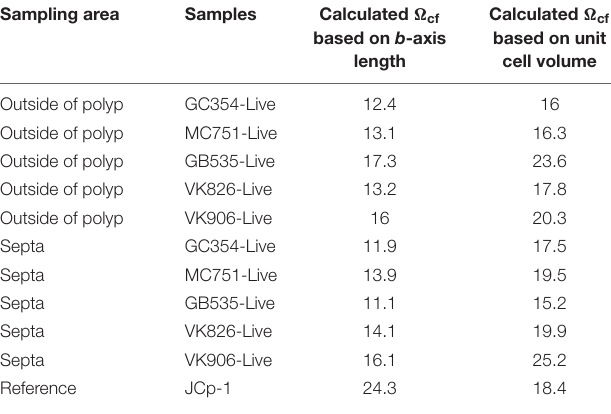
TABLE 2 | Internal calcifying fluid aragonite saturation state ( (cid:127) cf ) estimates in live L. pertusa samples from the Gulf of Mexico as calculated by the relationship between aragonite saturation states and b -axis lengths or unit cell volumes in synthetic